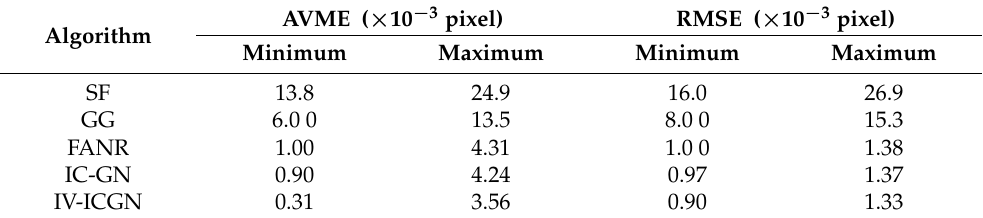
Table 1. Comparison of the absolute value of the mean error and the root mean square error value of the five